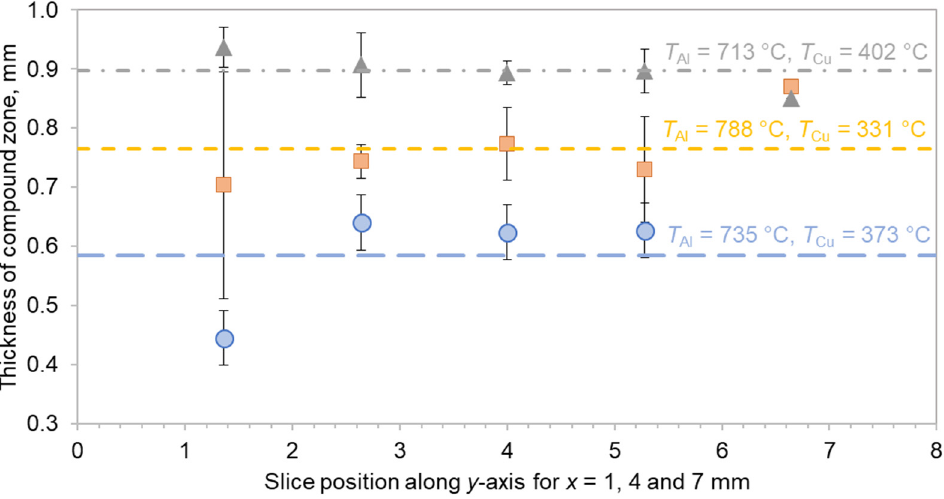
Figure 6. Compound zone thicknesses of three different specimens, measured at different positions along the y -axis (for the coordinate system used, see Figure 5).